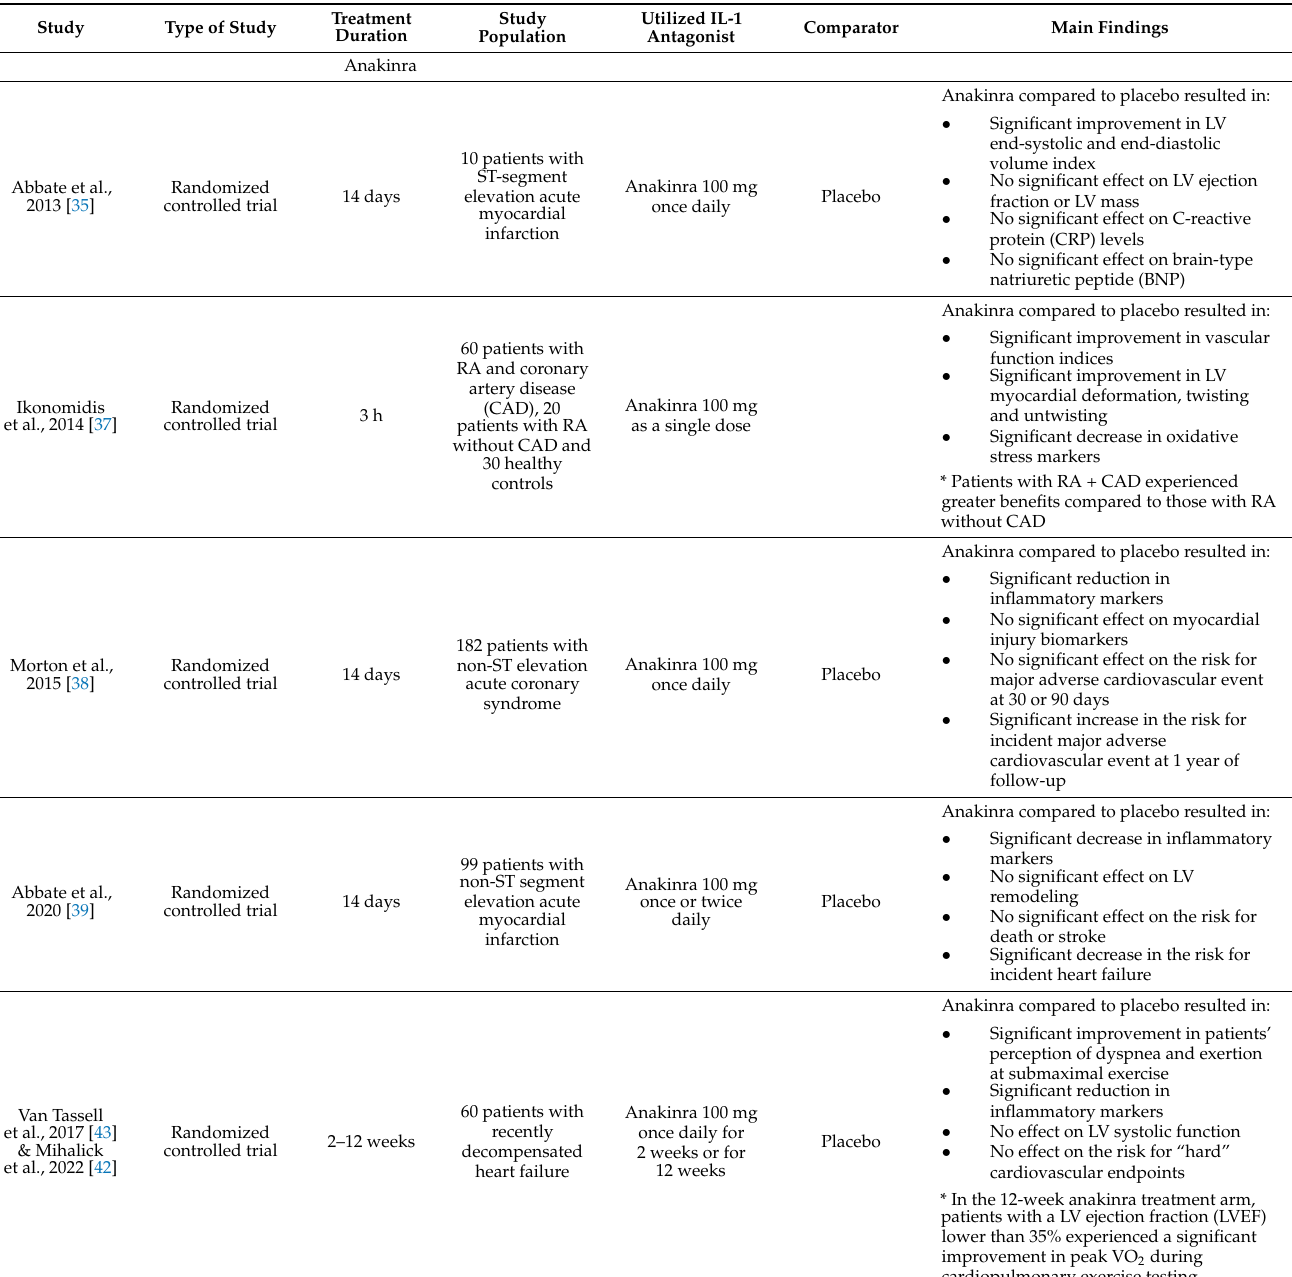
Table 1. Overview of randomized controlled trials assessing the cardiovascular effects of IL-1